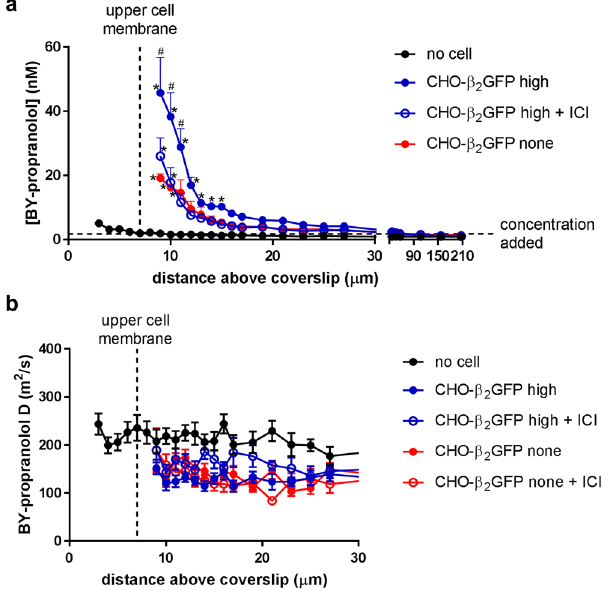
Figure 2. Role of the presence of the target receptor and the cell membrane on local BY-propranolol concentrations and diffusion coefficients. ( a , b ) Local concentrations ( a ) and diffusion coefficients ( b ) of BY- propranolol measured 2–200 µ m above membranes of receptor expressing (high) CHO- β 2 GFP cells in the absence (n = 13) and presence of 550 nM ICI 118,551 (ICI; n = 7) and non-receptor expressing (none) CHO- β = 10) following 2 hours BY-propranolol incubation. The same experiments were carried out in 2 GFP cells (n areas of no cell (3–207 µ m above the coverslip; absence of antagonist only; n = 8). Data shown are mean ±